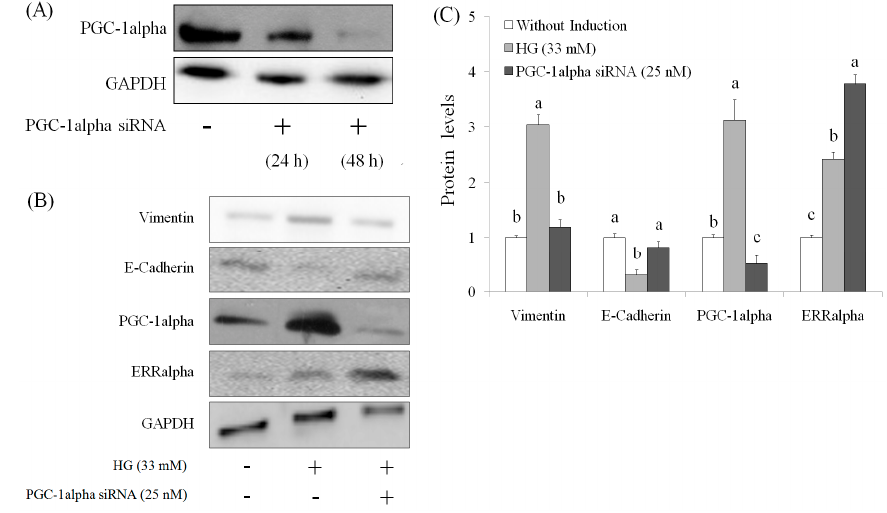
Figure 6. Effects of PGC-1alpha knockdown treatment on epithelial-mesenchymal transition (EMT) markers in high glucose (HG)-induced OVCAR-3 carcinoma cells. ( A ) The cells were treated with